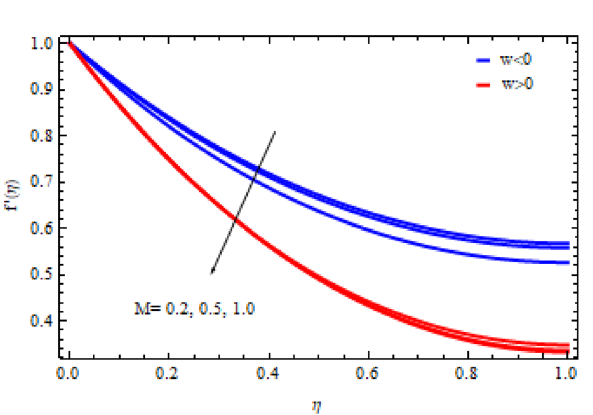
Table 3. Assessment of f ′′ ( 0 ) and values of (cid:31) and Pr , respectively.